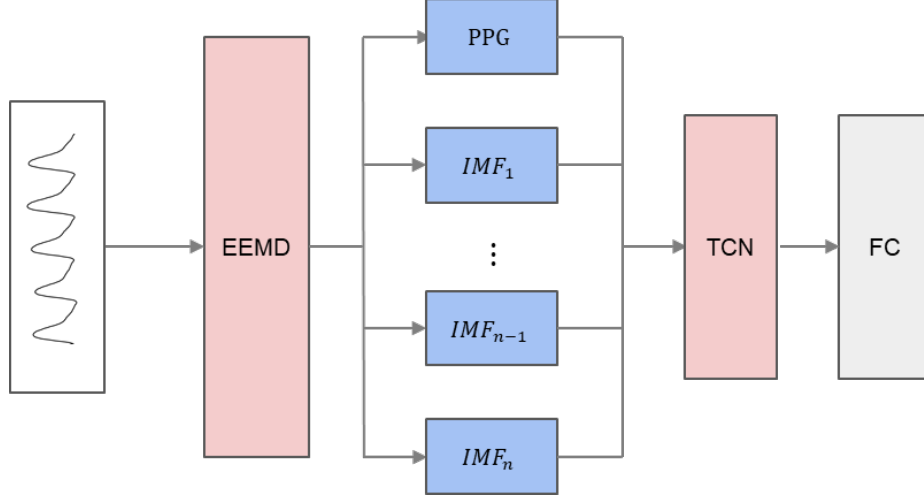
Figure 3. Structure diagram of EEMD-TCN prediction model.